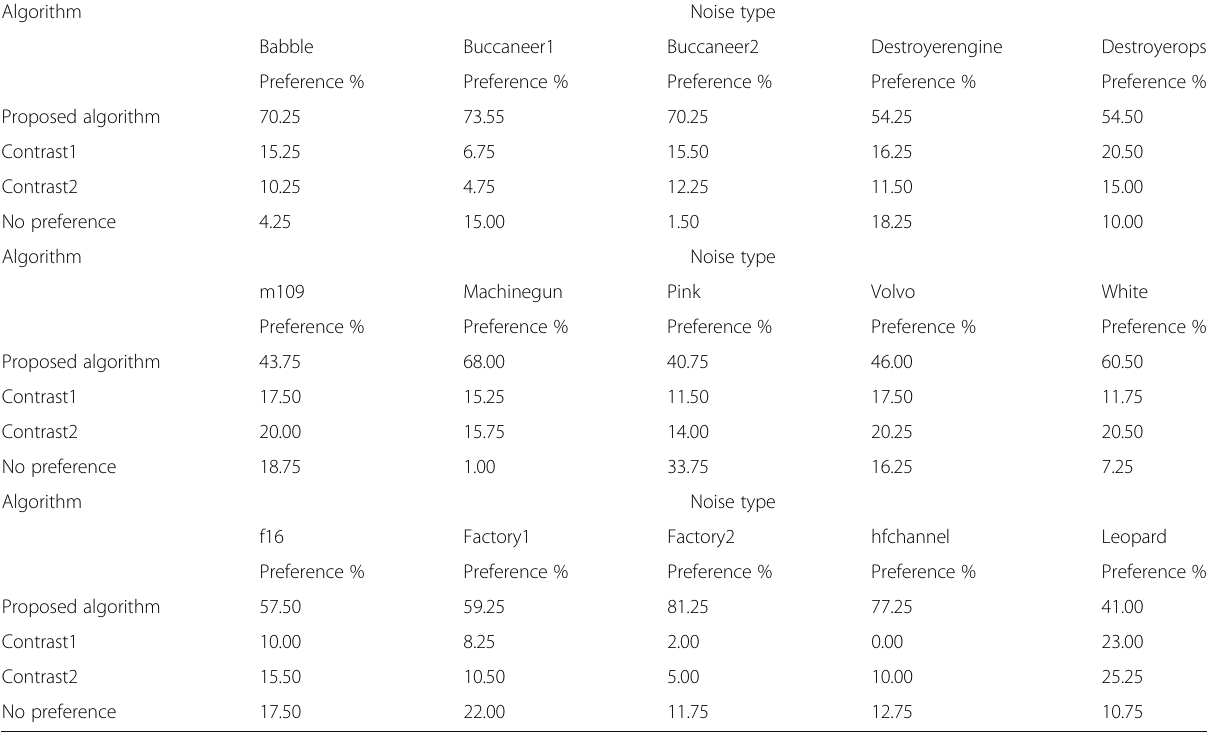
Table 5 The A/B test of the proposed algorithm and the contrast algorithm with 15 noise types